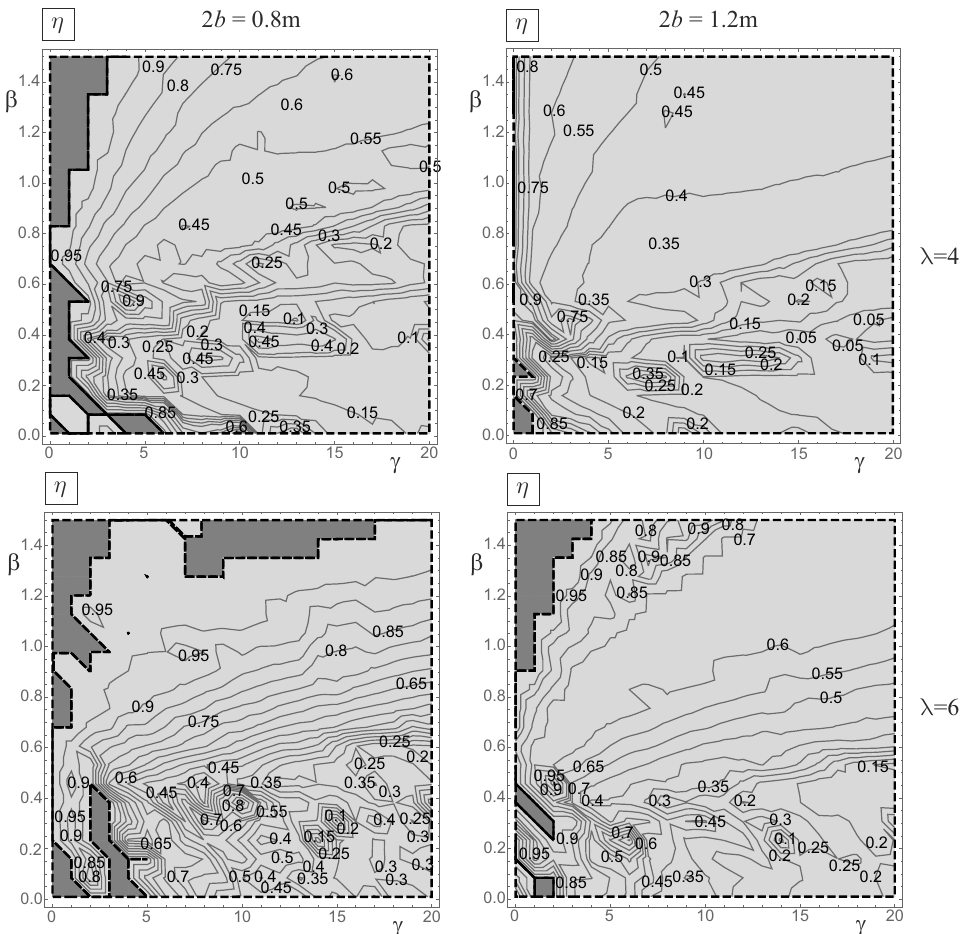
Figure 14. Gain maps obtained for different dimensions of the rigid blocks and under the Christchurch seismic record ( m = 0.05 M , u y = 1/3 u cr , ψ =